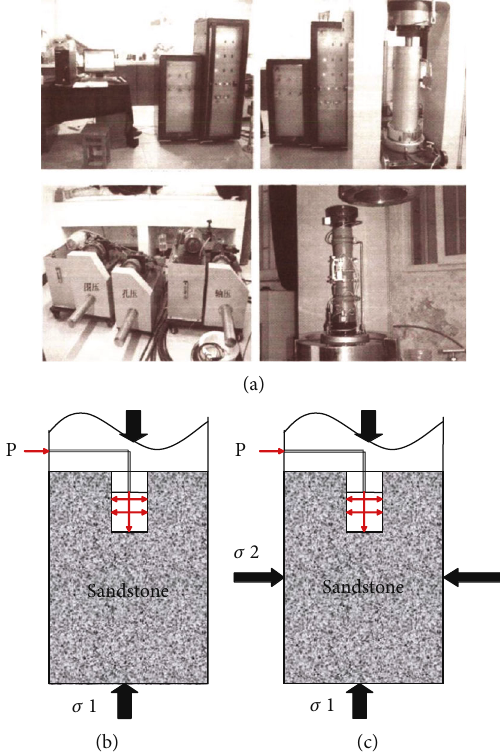
Figure 1: Schematic diagram of sandstone hydrofracture. (a) The RLW-2000M rock mechanical testing system and deformeter. (b) Uniaxial hydraulic failure. (c) Triaxial water pressure